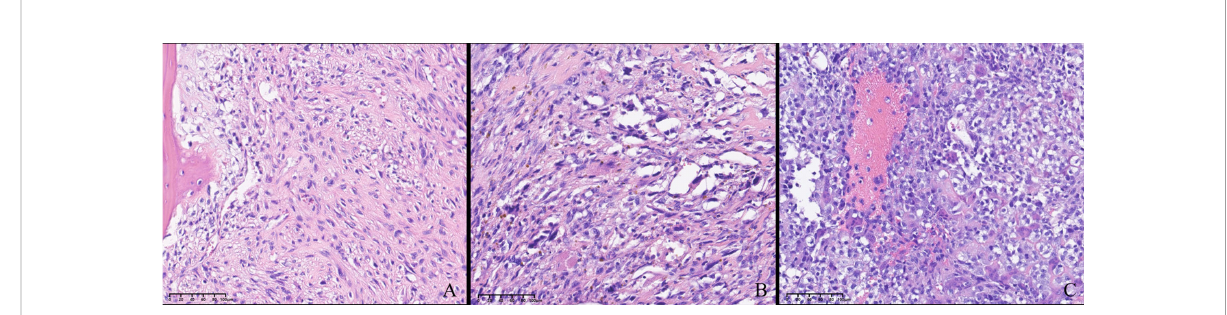
FIGURE 1 (A) Image of conventional osteosarcoma hematoxylin and eosin (H&E) staining (200×). (B) Image of telangiectatic osteosarcoma H&E staining (200×). (C) Image of small-cell osteosarcoma H&E staining